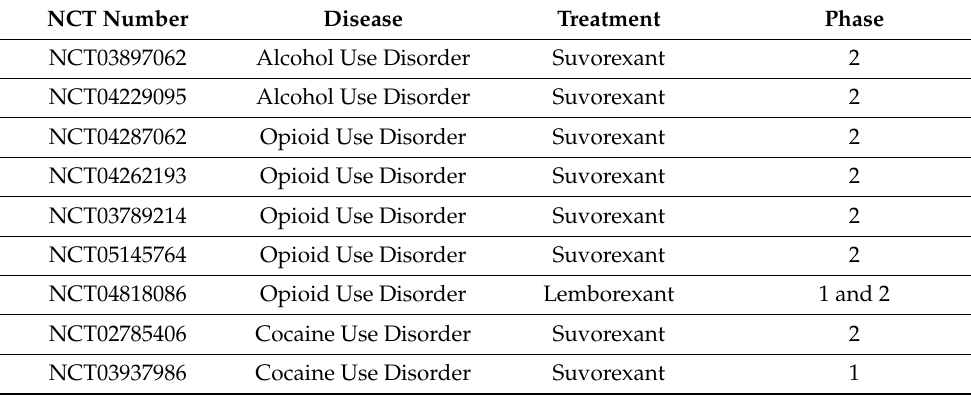
Table 3. Clinical trial on drug use disorders targeting the orexin